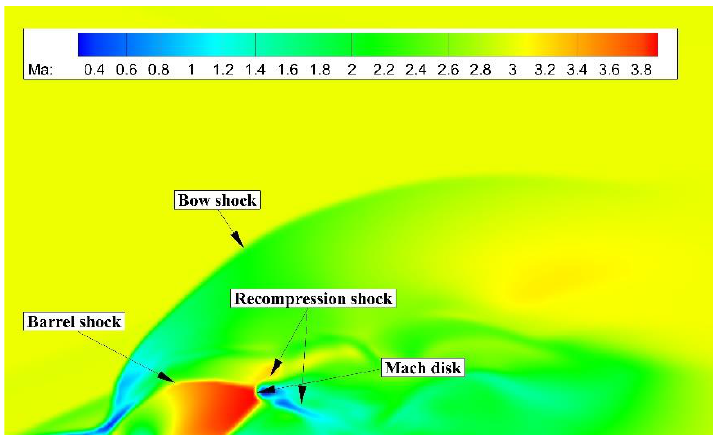
Figure 5. Mach number contour at symmetric surface.